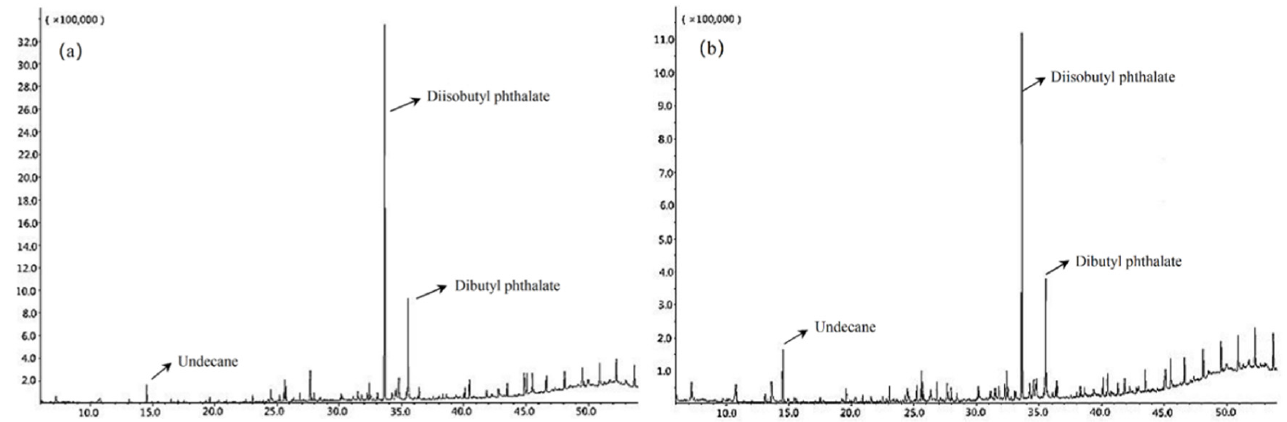
Figure 7. GC-MS patterns: ( a ) raw water, ( b ) water samples treated by Fenton process.